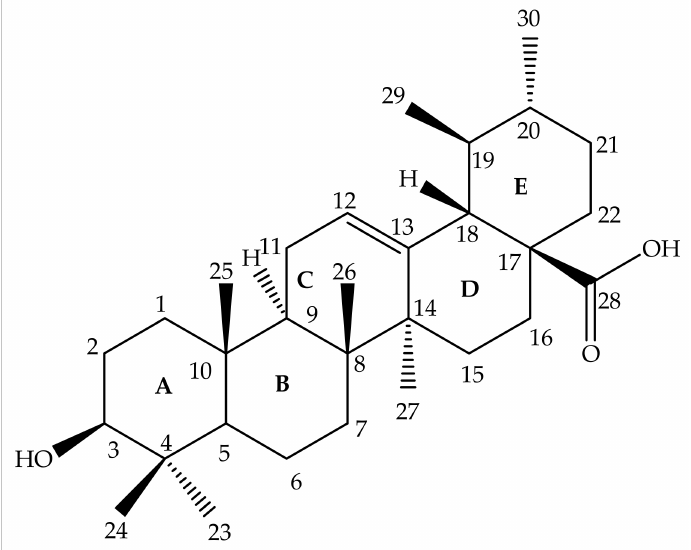
Figure 1. Ursolic acid chemical